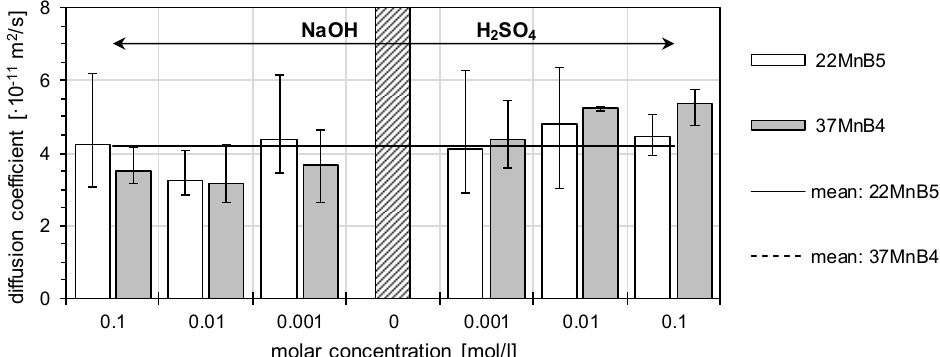
Figure 11. Comparison of the determined diffusion coefficients (mean value of t b , t lag and t WP ) for the quenched and tempered steels 22MnB5 and 37MnB4 for alkaline and acid solutions at a current density of 100 mA/dm 2 .